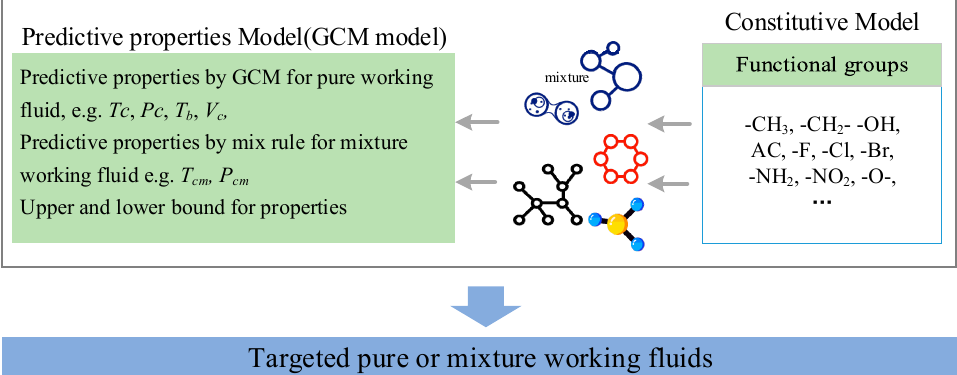
Figure 1. The methodology for the design of working fluids.